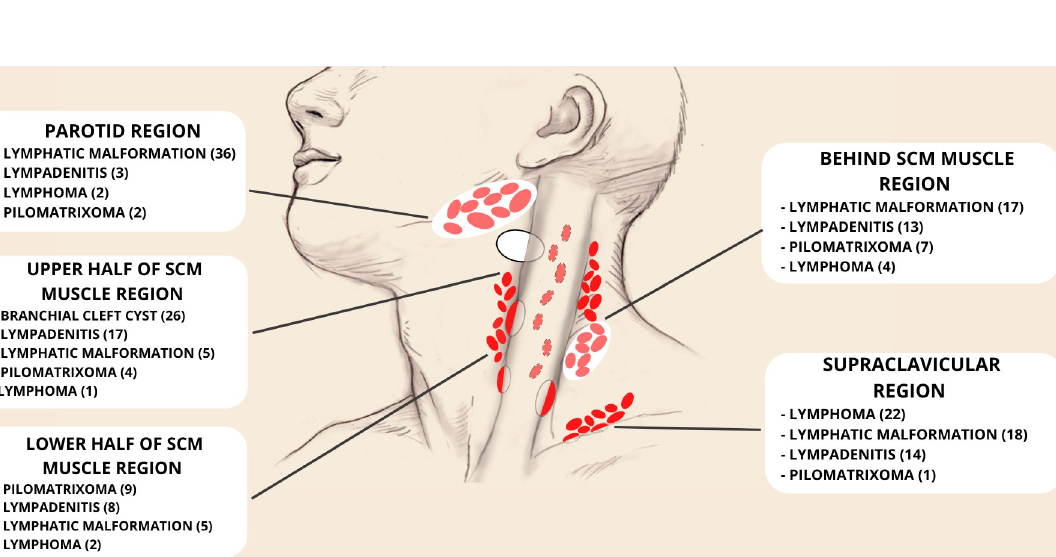
PLOS ONE | https://doi.org/10.1371/journal.pone.0251563 May 12,